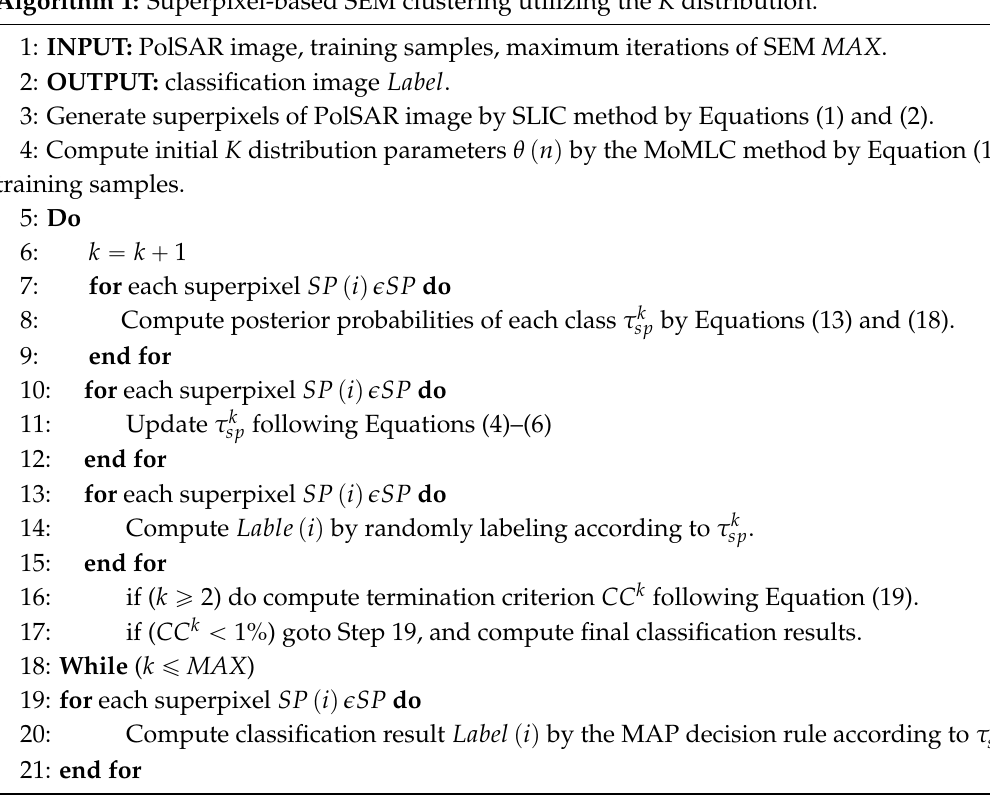
Algorithm 1: Superpixel-based SEM clustering utilizing the K